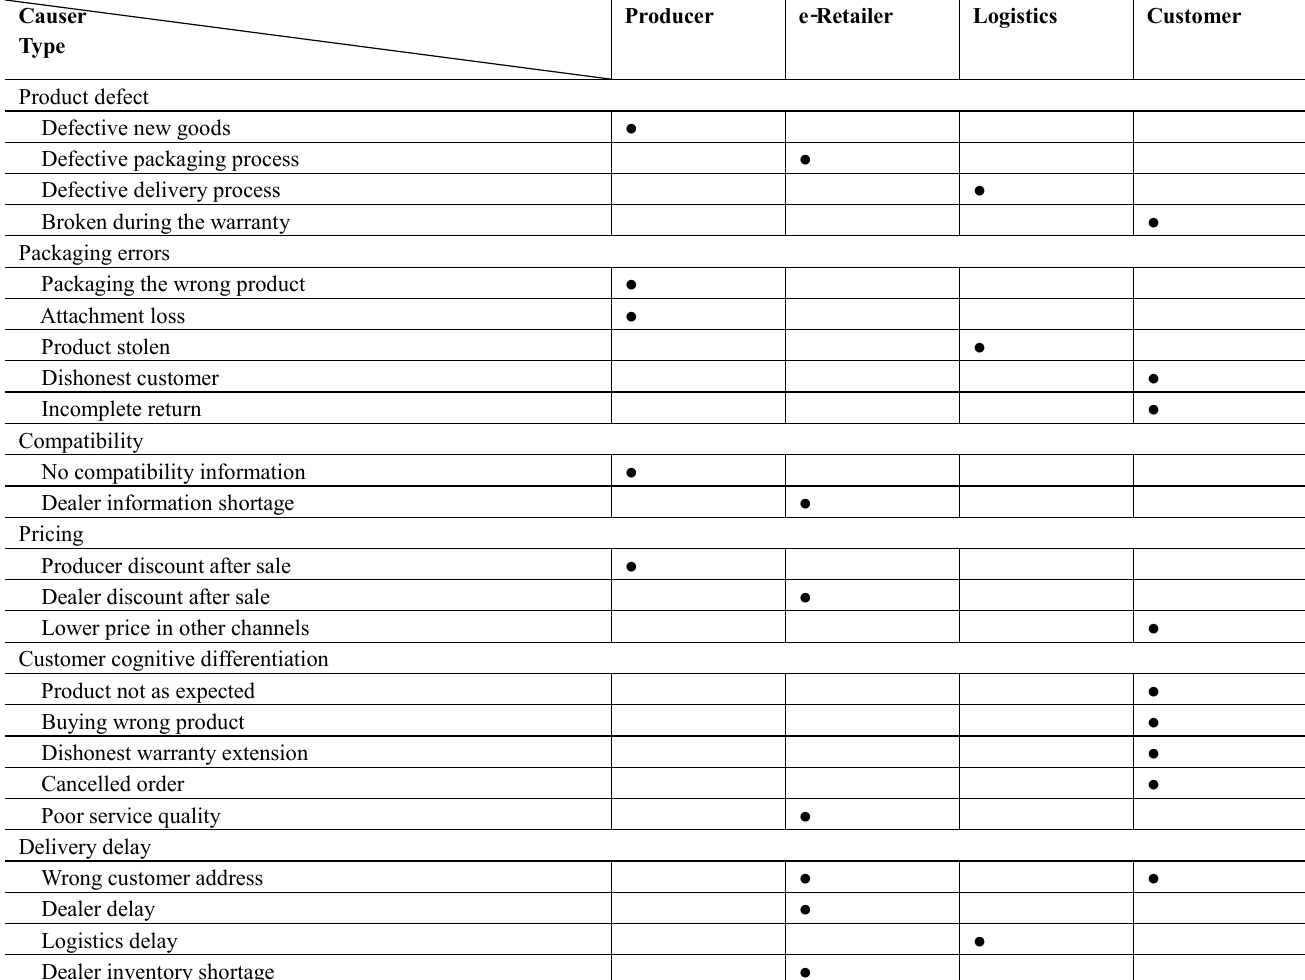
Table 1: Service failure classification of